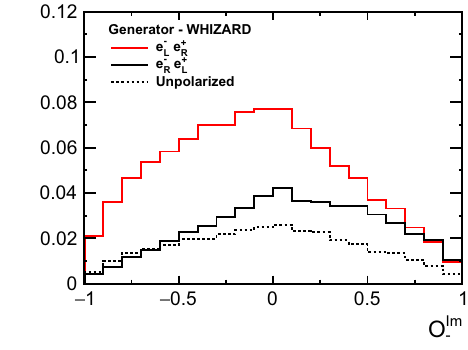
Fig. 2 The WHIZARD LO Standard Model prediction for the normal- ized distribution of the CP observables O Re − (left panel) and O Im − (right panel) defined in (12) and (13). The results correspond to e + e − colli- sions at a centre-of-mass energy of 500 GeV and three different beam polarizations:thedashedlinecorrespondstounpolarizedbeams,thered (black) solid lines to − 80% (+ 80%) polarization of the electron beam